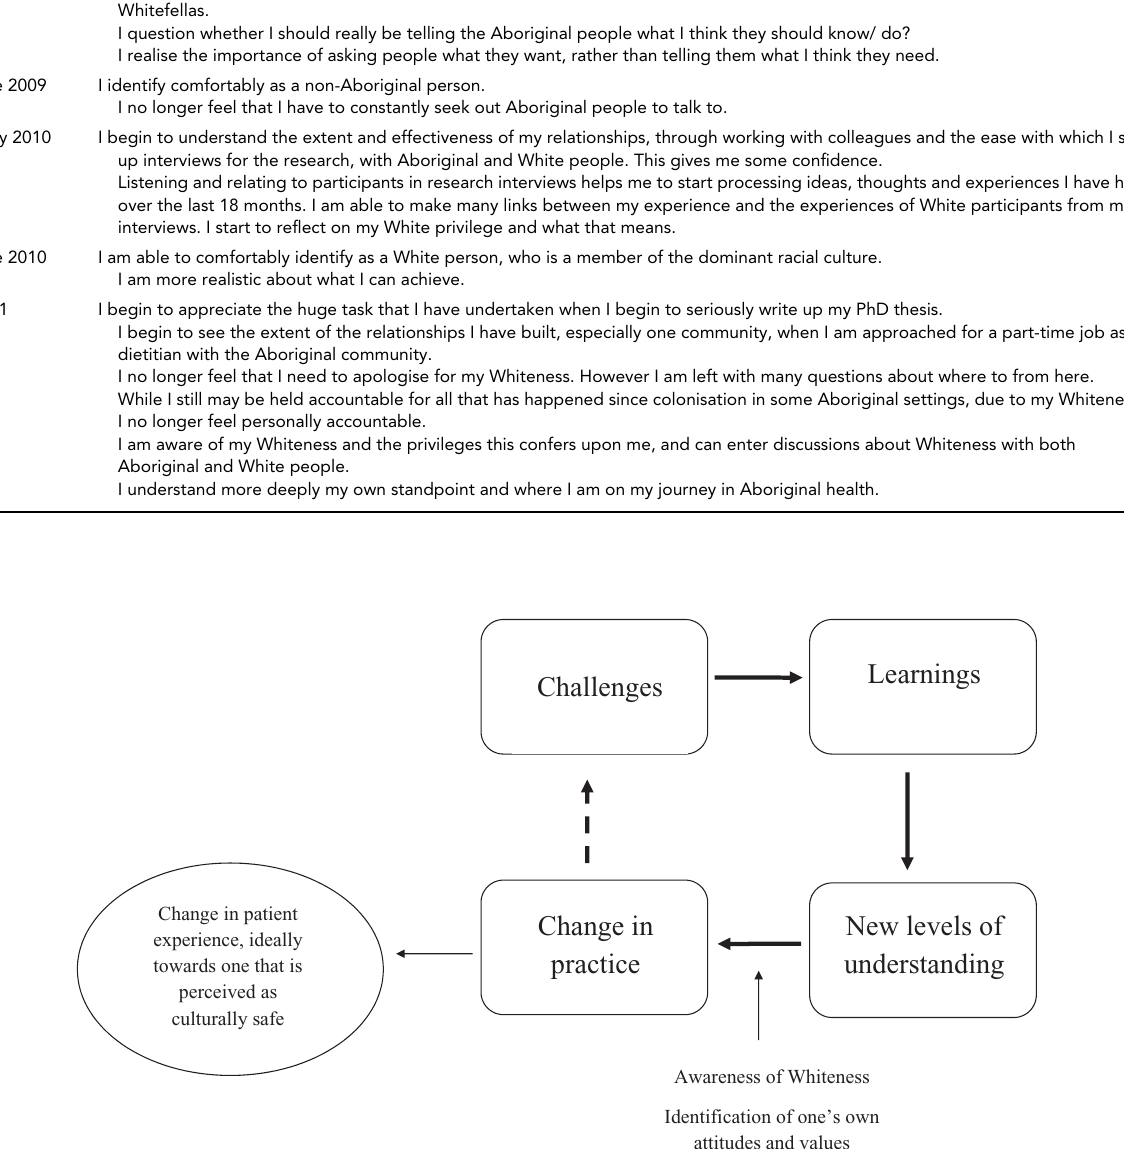
226 THE AUSTRALIAN JOURNAL OF INDIGENOUS